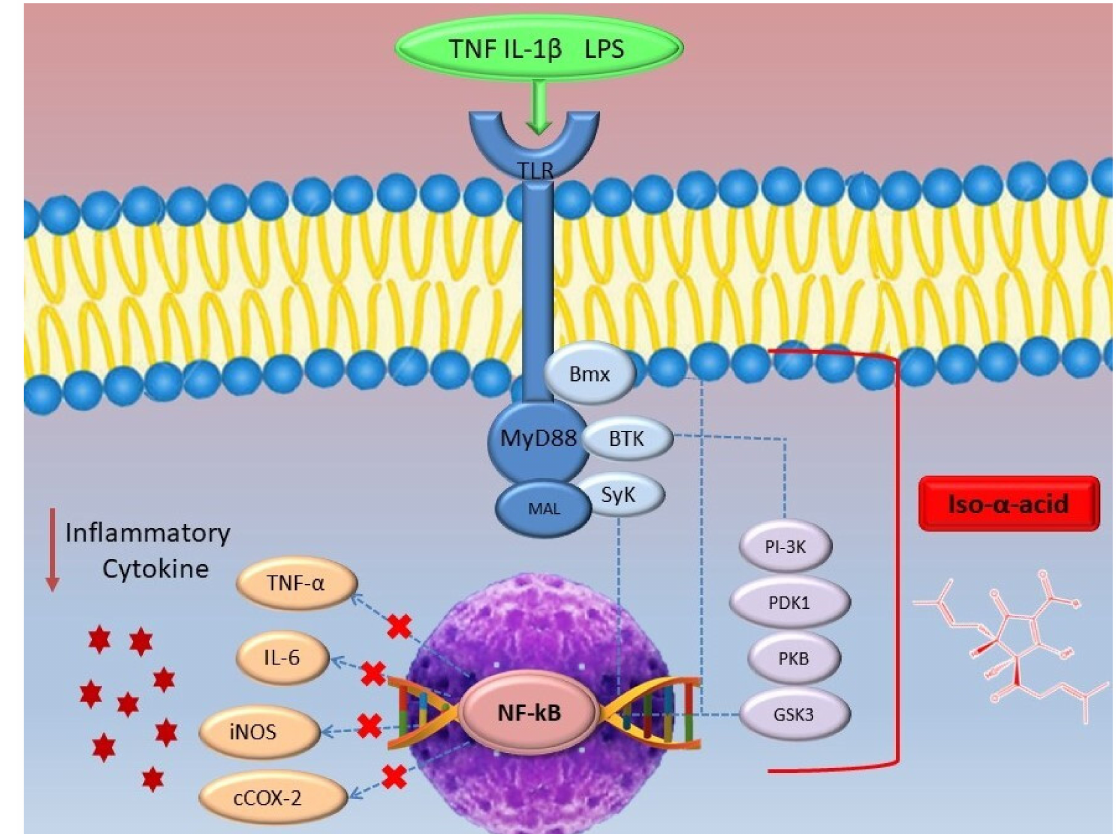
Figure 9. Iso- α -acids can exert anti-inflammatory activity by inhibiting the NF-kB pathway by acting on several kinases involved upstream and downstream of the signal transduction. Consequently, the dysregulated secretion of adipokines and pro-inflammatory cytokines related to obesity